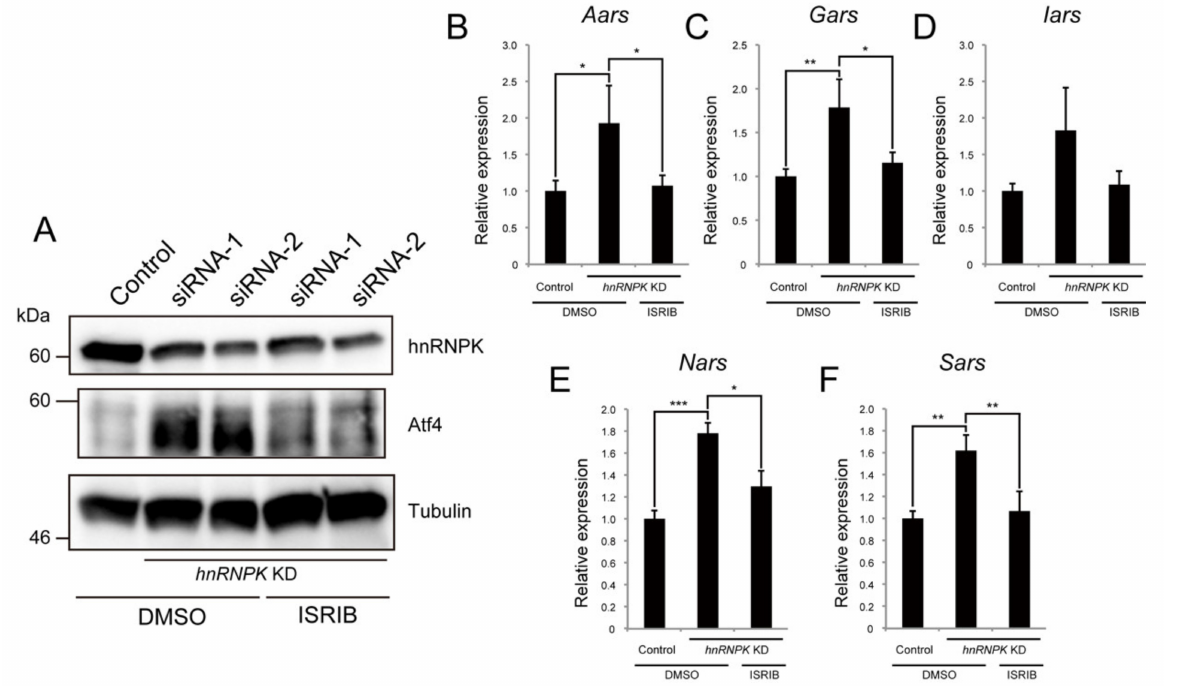
Figure 6. hnRNPK regulates the expression of genes coding for aminoacyl-tRNA synthetases via the eIF2 α /Atf4 pathway. ( A ) Western blot showing the increased Atf4 expression 48 h after hnRNPK KD, and ISRIB treatment suppressed the increase. Dimethyl sulfoxide (DMSO) was used as the control. The blots shown are representative of three experiments. ( B – F ) qRT-PCR to detect the expression of Aars ( B ), Gars ( C ), Iars ( D ), Nars ( E ), Sars ( F ) 48 h after hnRNPK KD with or without ISRIB treatment. n = 3, mean ± SD. *** p < 0.001, ** p < 0.01, * p <